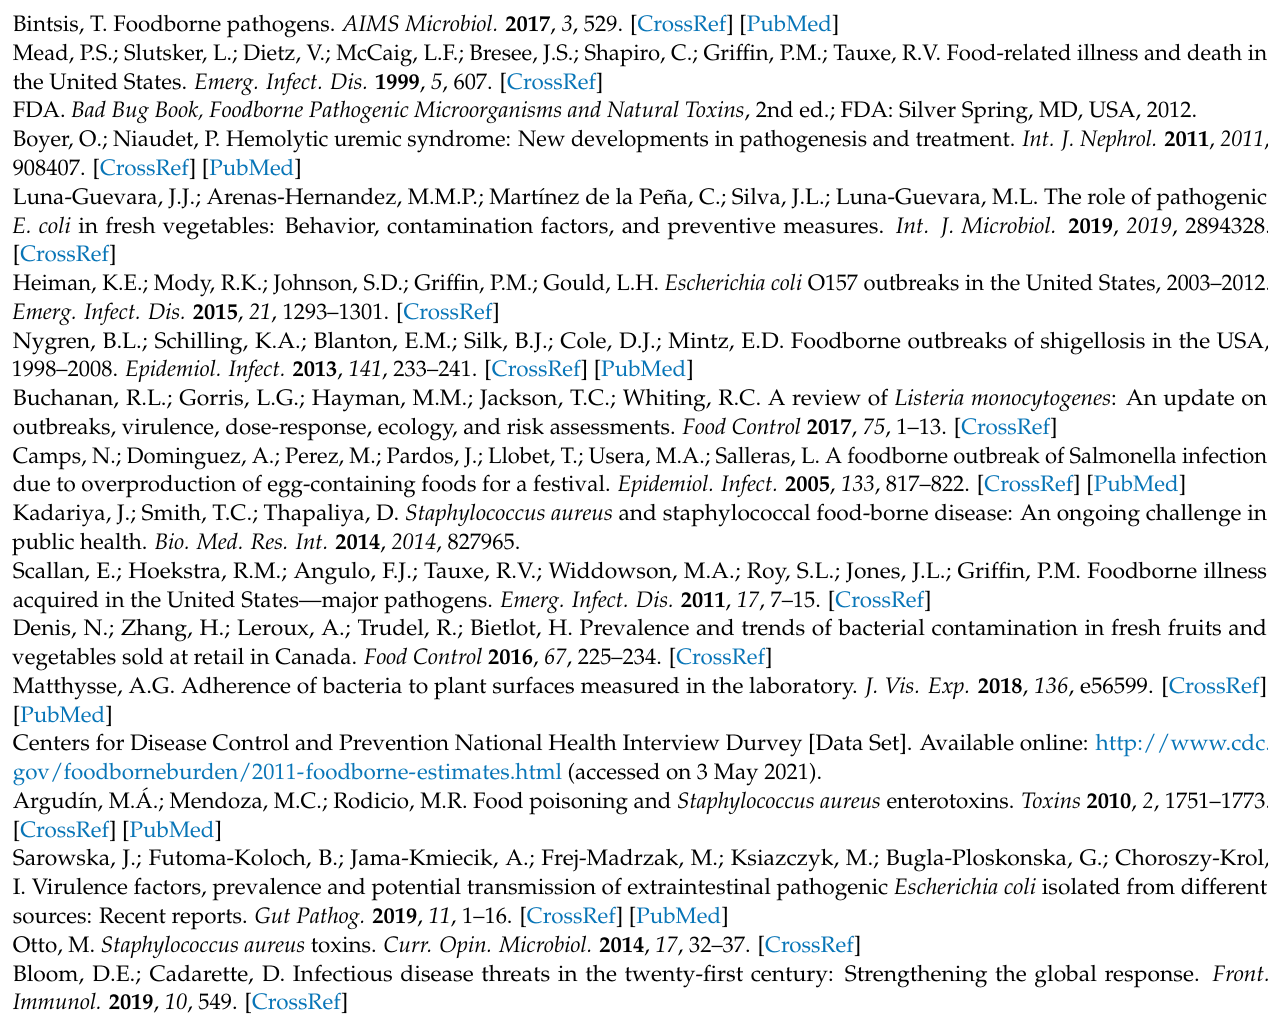
the optimal experimental conditions. Figure S2: Examination of the optimal reaction time. Figure S3: Optimization of the concentration of hydrogen peroxide in the catalase reactions. Figure S4: Exami- nation of endogenous enzymatic reactions of four other model bacteria, Figure S5: Examination of the limit of detection of S. aureus-based endogenous enzymatic reactions, Figure S6: Examination of endogenous enzymatic reactions of the mixture of E. coli and A. niger . Figure S7: Photographs of the agar plates inoculated with the samples collected from door